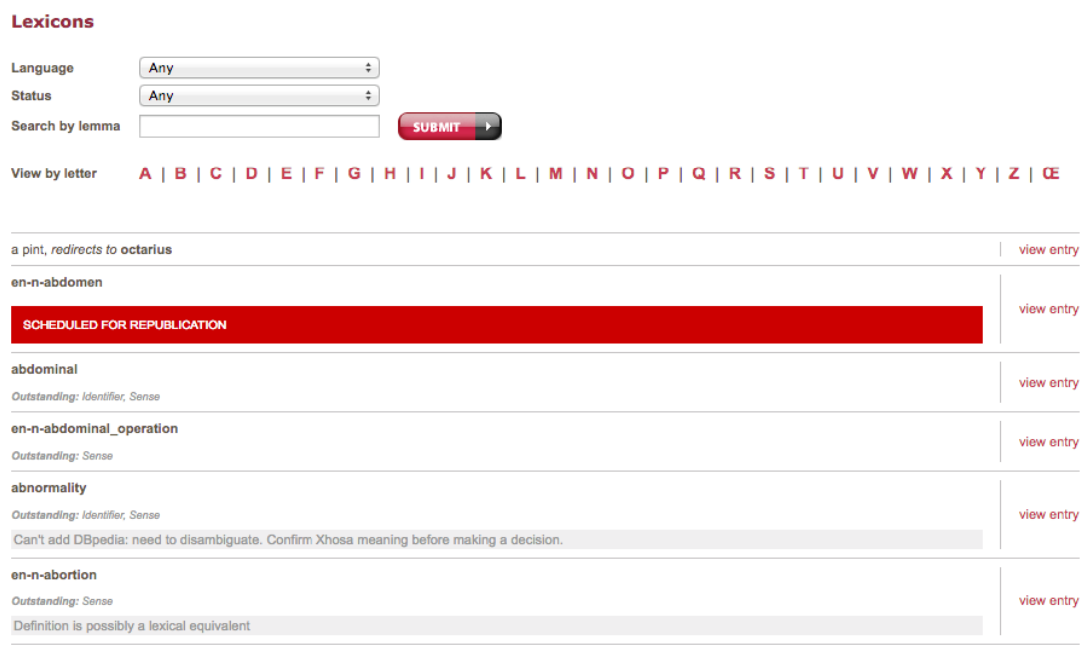
Figure 5. Selection of lexical entries in the DWS.